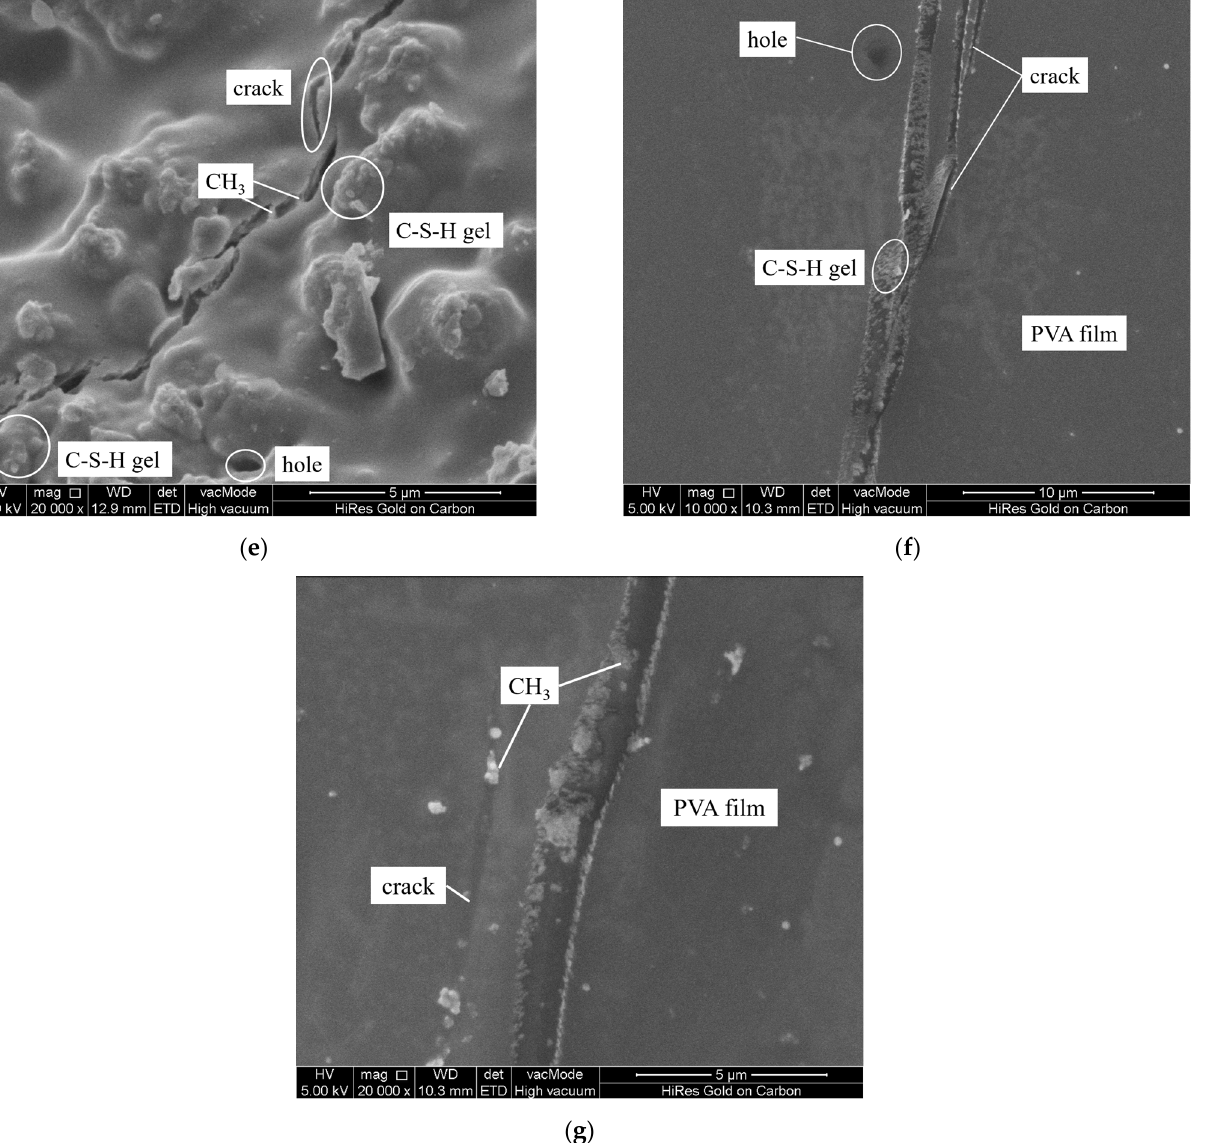
Figure 8. Micromorphology of the outer surface of RCA after different strengthening methods: ( a ) R0; ( b ) S1; ( c ) S2; ( d ) P1; ( e ) S1S2; ( f ) S1P1; and ( g ) S2P1.